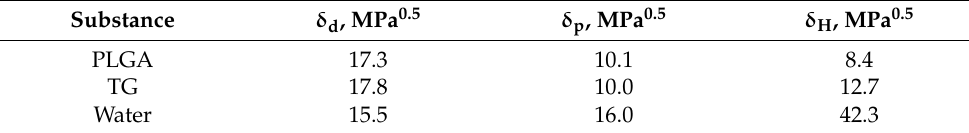
Table 1. Hansen’s solubility parameters of the substances used in this work.